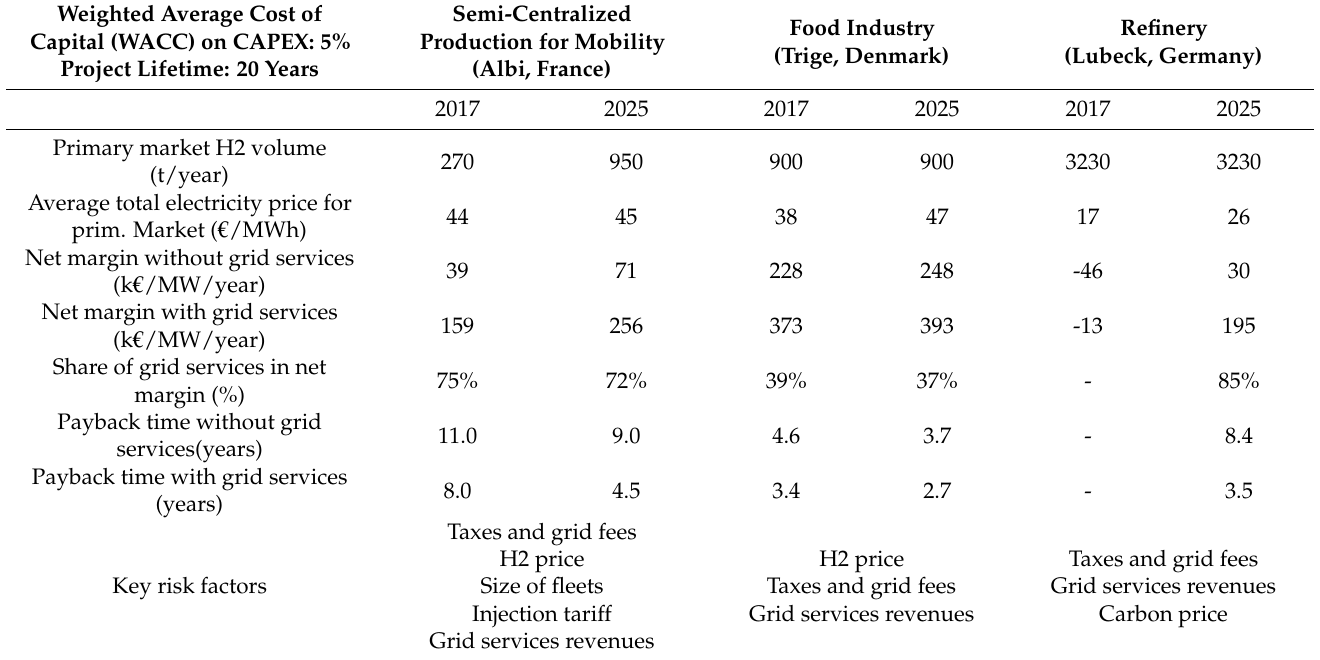
Table 12. Profitability results of the three best short-term business cases of the study